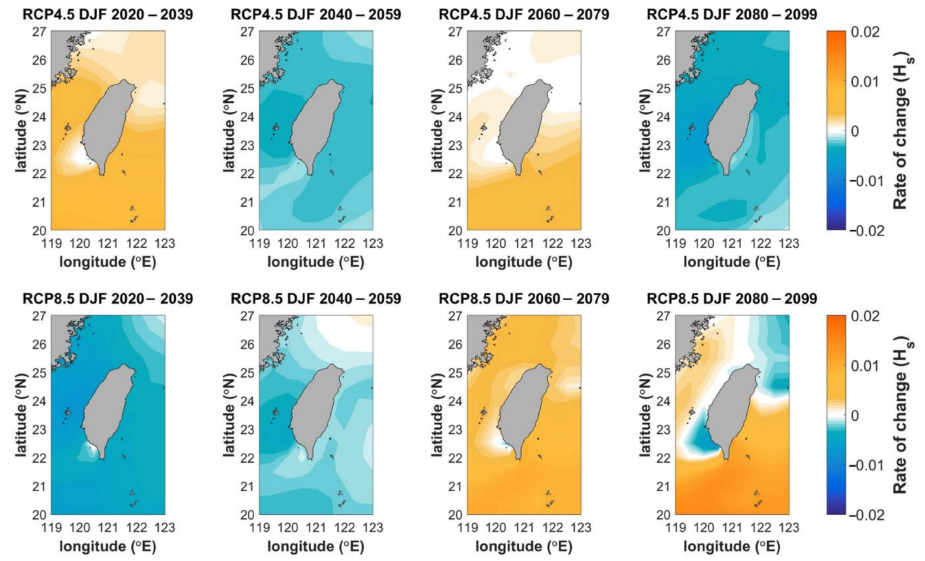
Figure 14. Rate of change in the seasonal mean of significant wave heights for each GCM, with respect to the reference period from 1980 to 2004 in the region of Taiwan in winter for various future periods (2020–2039, 2040–2059, 2060–2079, and 2080–2099) and scenarios (RCP4.5 and